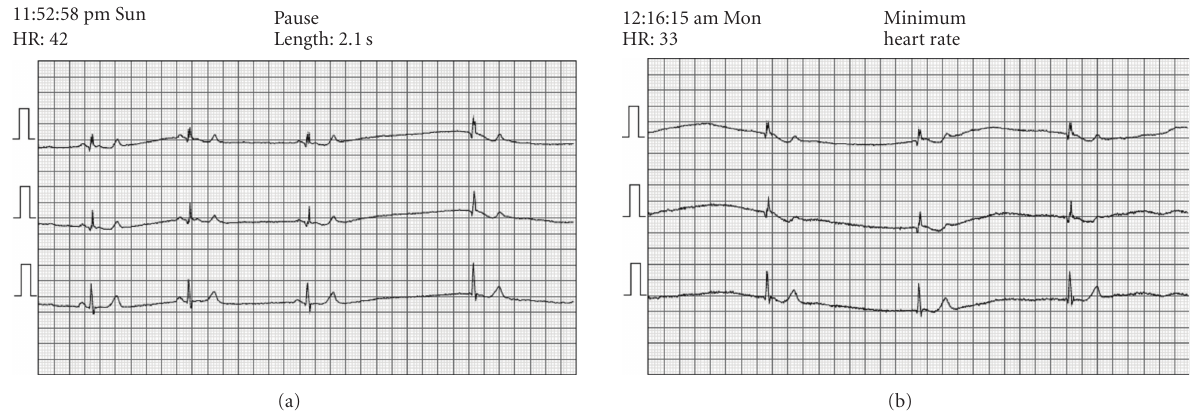
Figure 1: (a) Holter monitor recording showing sinus bradycardia at 42 bpm with sinus pauses of up to 2.1 seconds, corresponding to his prodromal symptoms while awake. (b) Holter monitor recording during a syncopal episode showing a drop in heart rate to 33bpm.